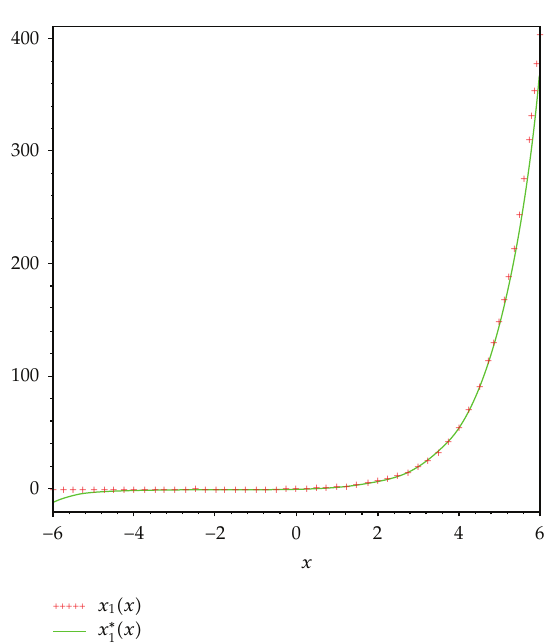
Figure 1: Values of x 1 (cid:3) x (cid:4) and its x ∗